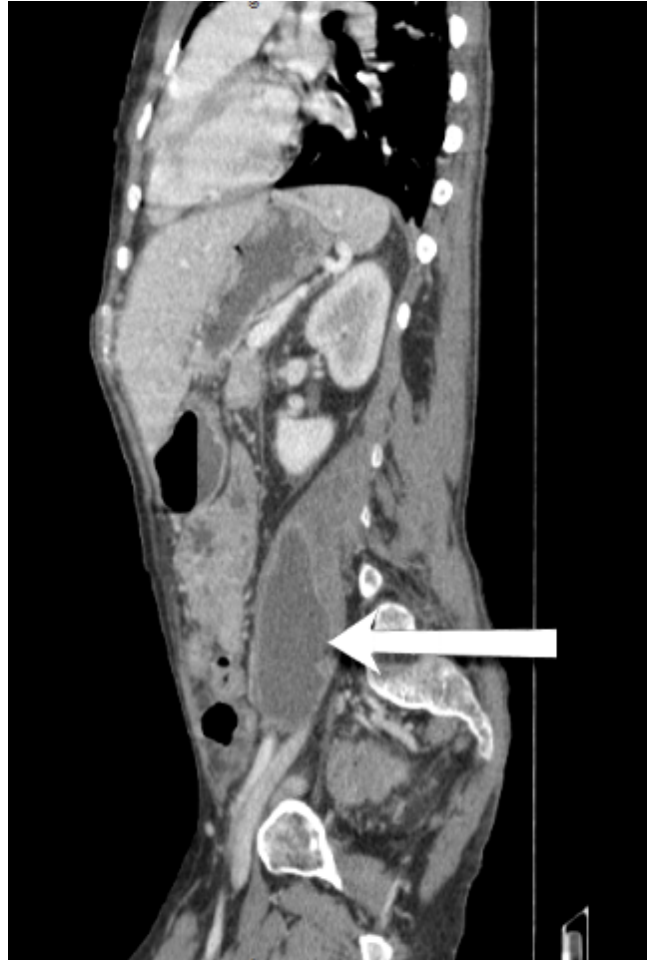
Figure 2. This is a sagittal image demonstrating the length and extent of infiltration of the psoas abscess.